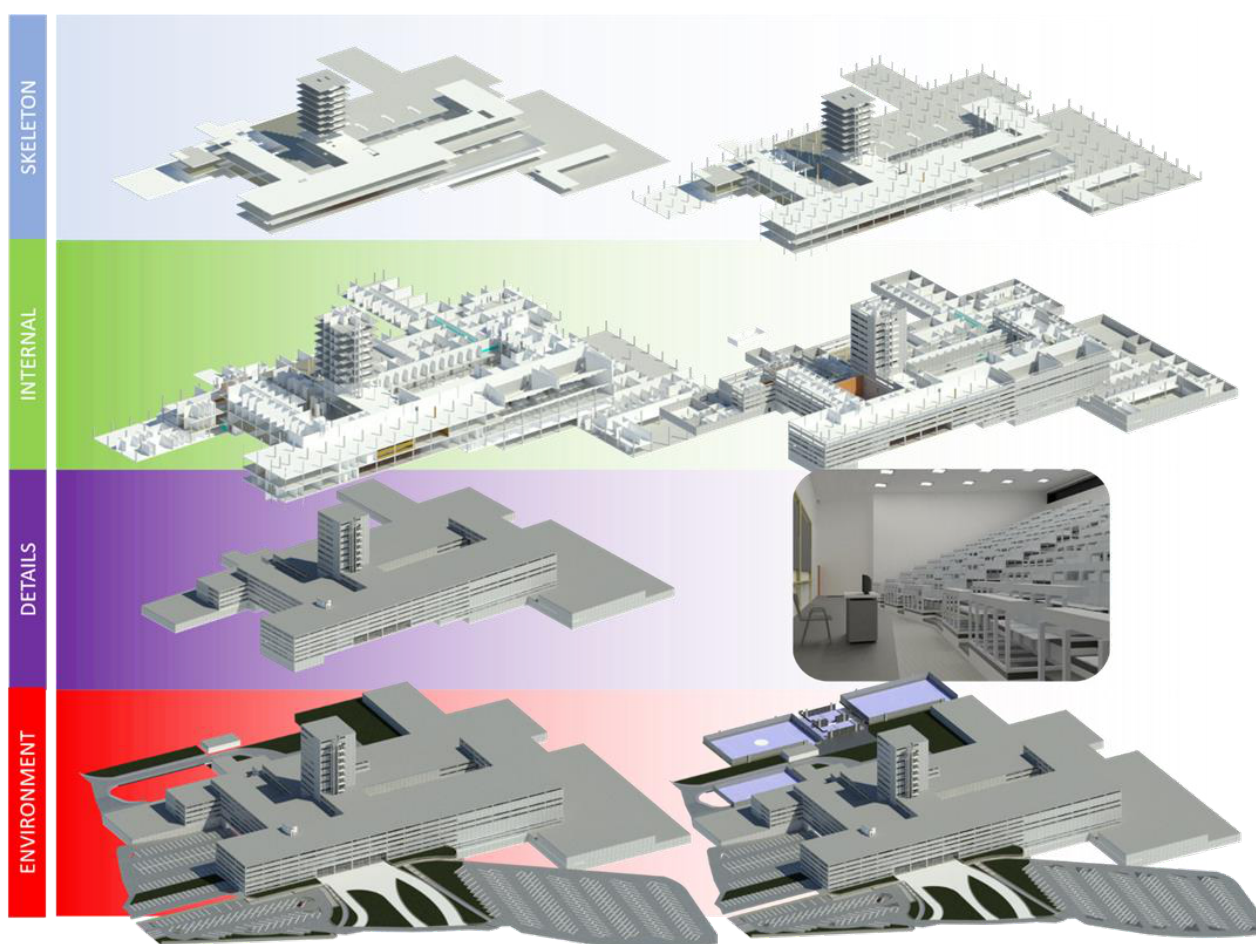
Figure 3. Flow chart of the BIM modelling.